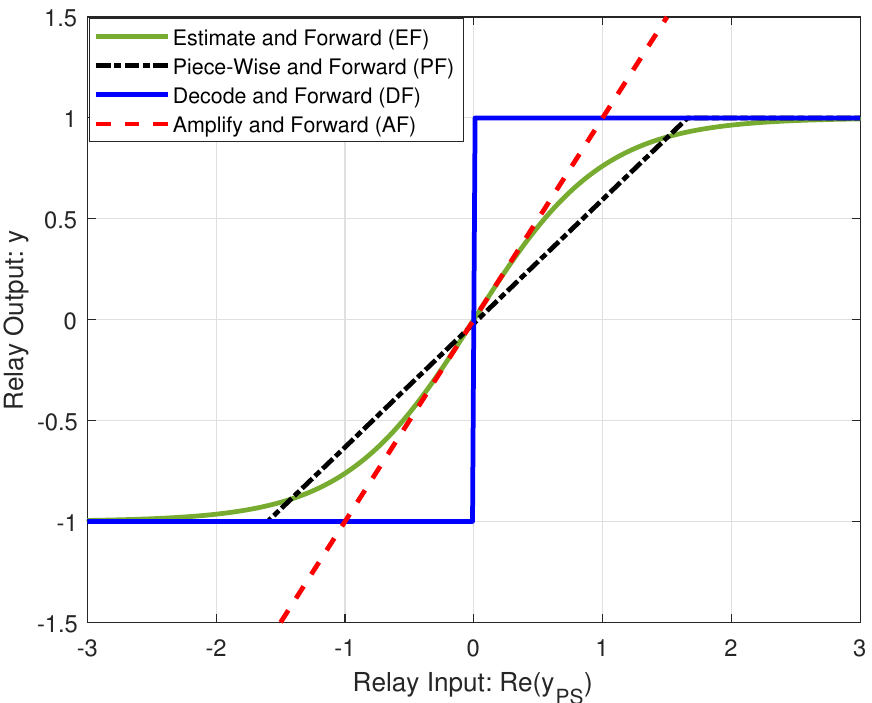
Figure 3. A comparison of the input–output relationship between different relaying